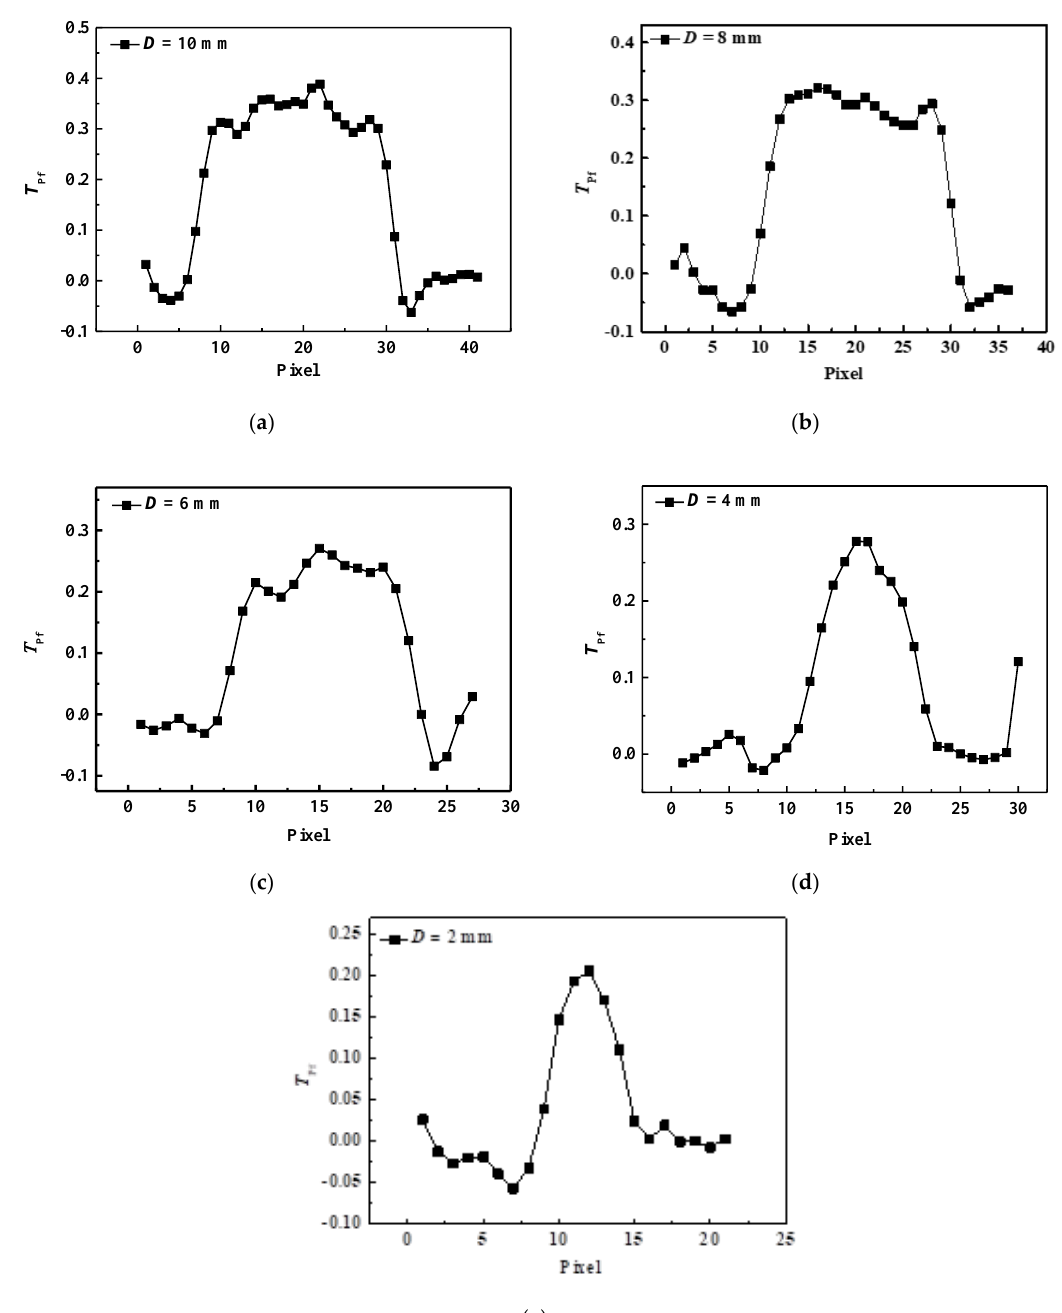
Figure 7. The temperature distribution around defects with different diameters after subtracting the fitting background: ( a ) D = 10 mm; ( b ) D = 8 mm; ( c ) D = 6 mm; ( d ) D = 4 mm and ( e ) D = 2 mm.